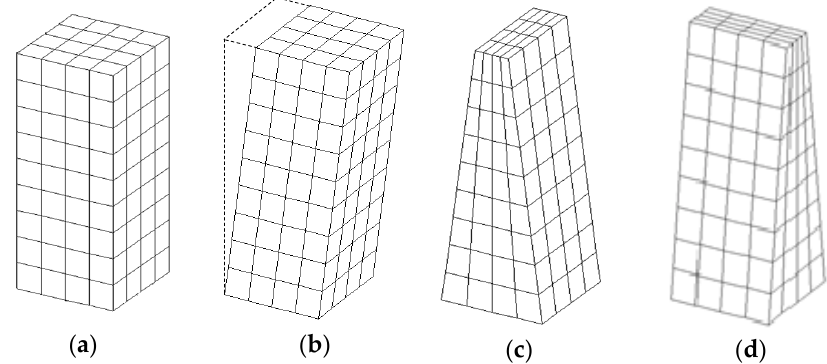
Figure 2. An example of original and basis shapes. ( a ) Original shape, ( b ) Basis Shape 1, ( c ) Basis Shape 2, ( d ) Basis Shape